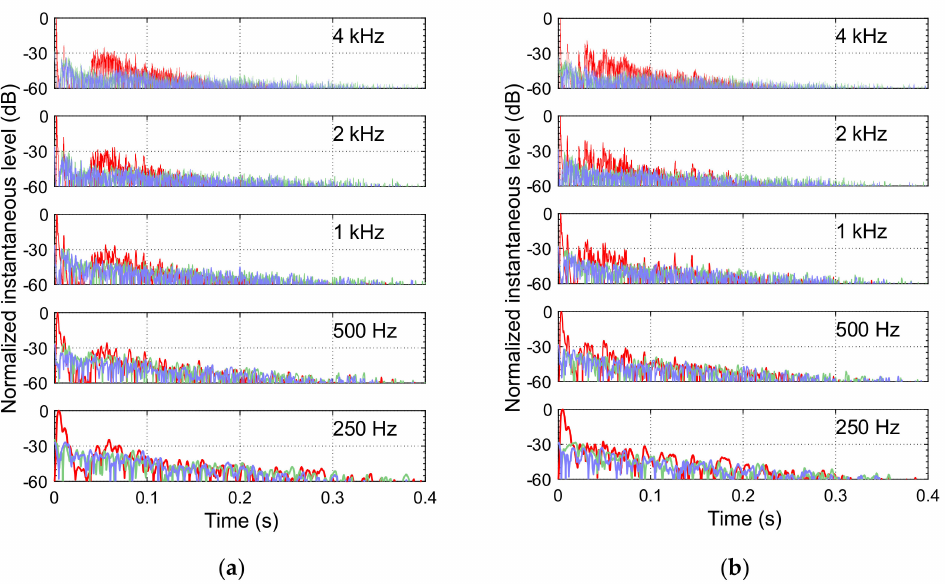
Figure 9. Lahan Vav octave-band impulse responses: ( a ) source at Position 1; ( b ) source at Position 6. The red line shows the impulse response for a receiver 0.5 m from the source; the blue and green lines show impulse responses for receivers about 10 m from the source. Arrivals are time-aligned, and levels are with respect to the red line’s direct sound peak. The visual display is simplified by taking the absolute value of the Hilbert transform.